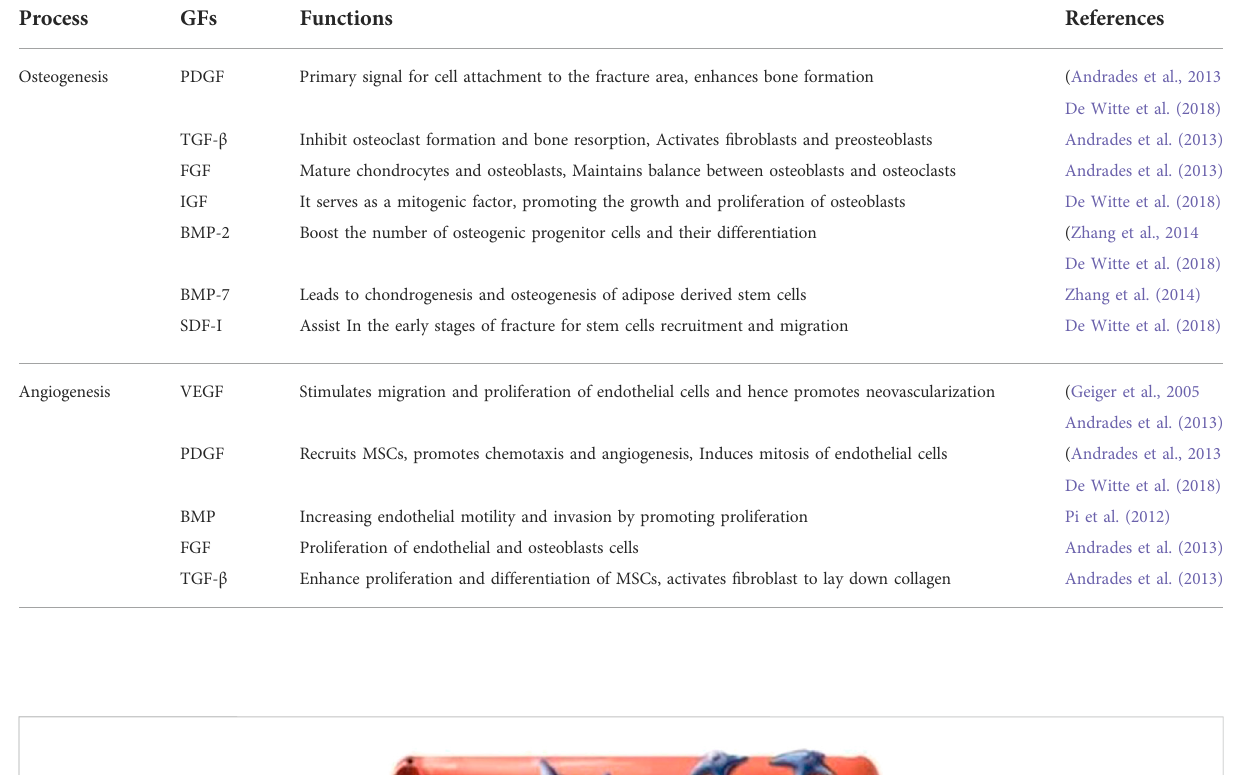
TABLE 1 Summary of various growth factors and their functions that promote osteogenesis and angiogenesis.